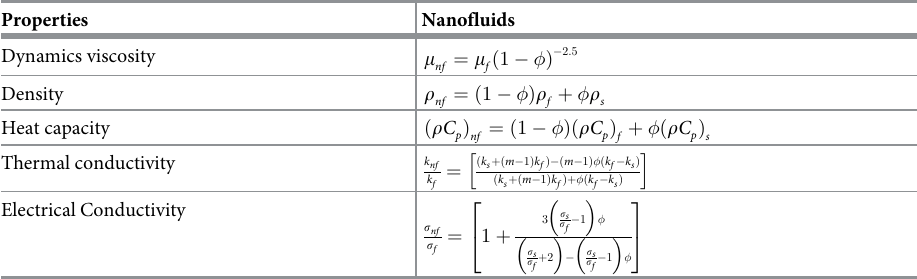
Table 1. Thermo-physical features for nanofluid.